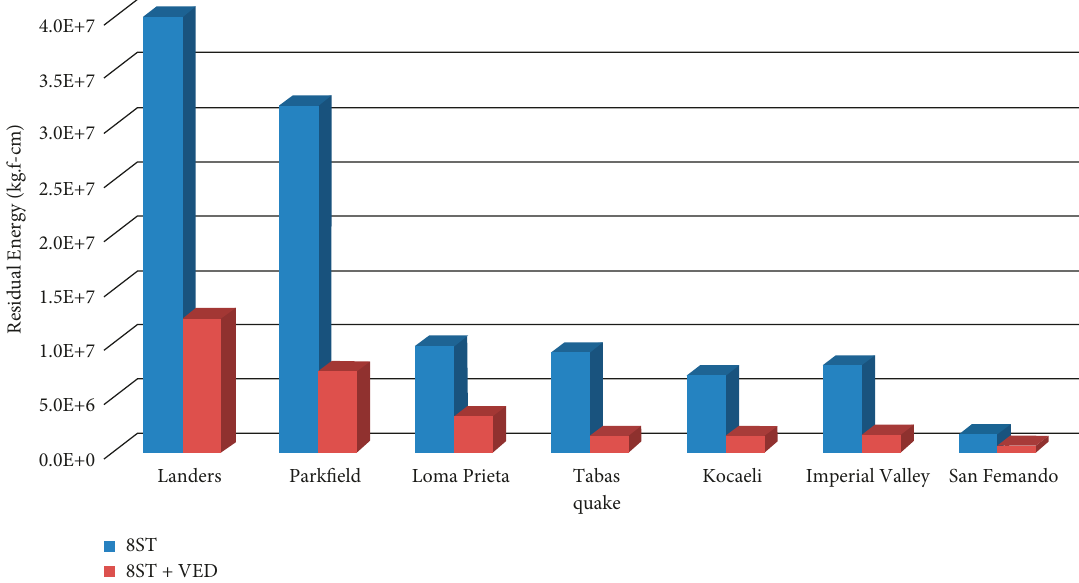
Figure 13: Residual energy diagram in an 8-story frame under near-field records, in two modes with and without